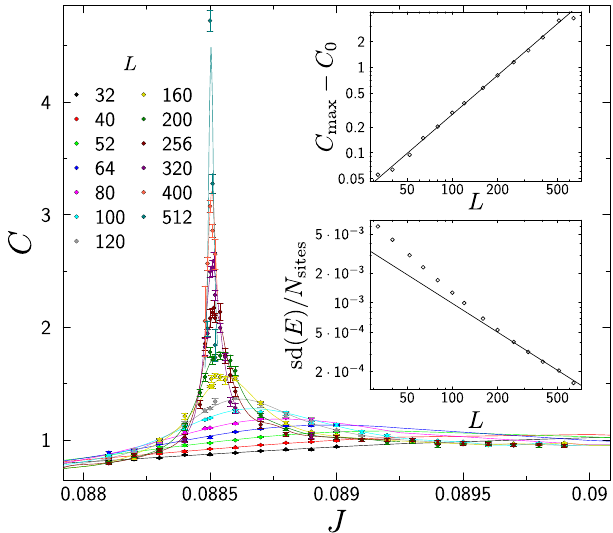
FIG. 6. Main panel: Heat capacity C versus J . Upper inset: Peak height C with constant C 0 ¼ 0 . 9836 subtracted to account for max background.Thefitisthepowerlawwithexponent α = ν ¼ 1 . 52 ð 2 Þ . Lowerinset:Standarddeviationinenergyat J ¼ 0 . 08850 .Thefitis with exponent ð α = ν − 3 Þ = 2 ¼ − 0 . 97 ð 4 Þ